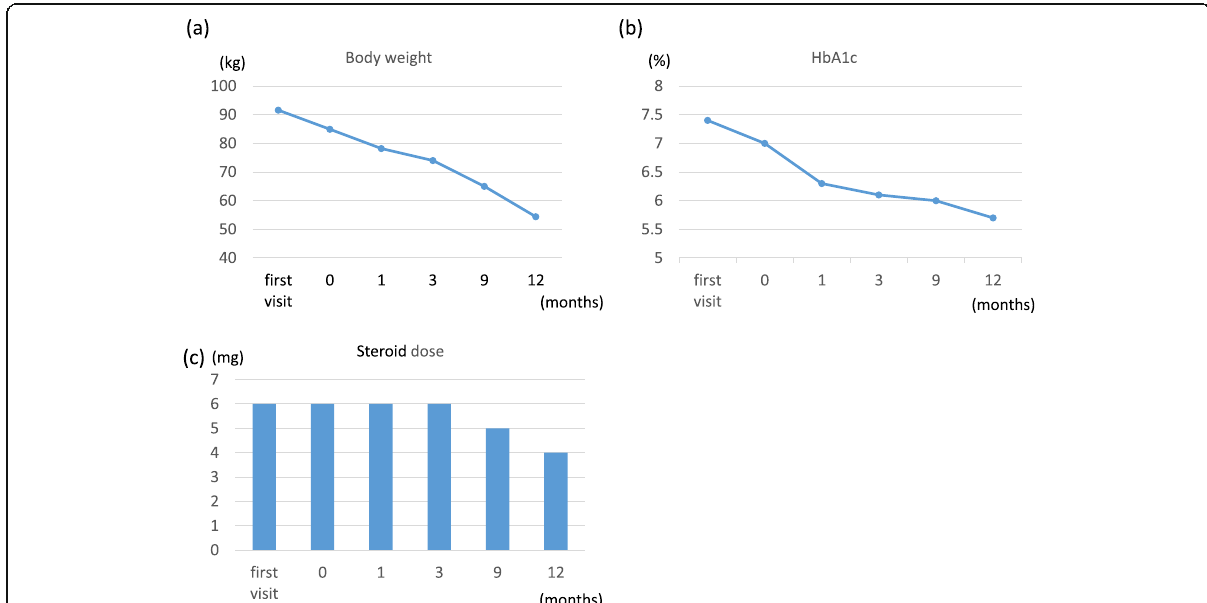
Fig. 1 a Body weight change from baseline to 1 year after the surgery. b HbA1c change from baseline to 1 year after the surgery. c Steroid dose change from baseline to 1 year after the